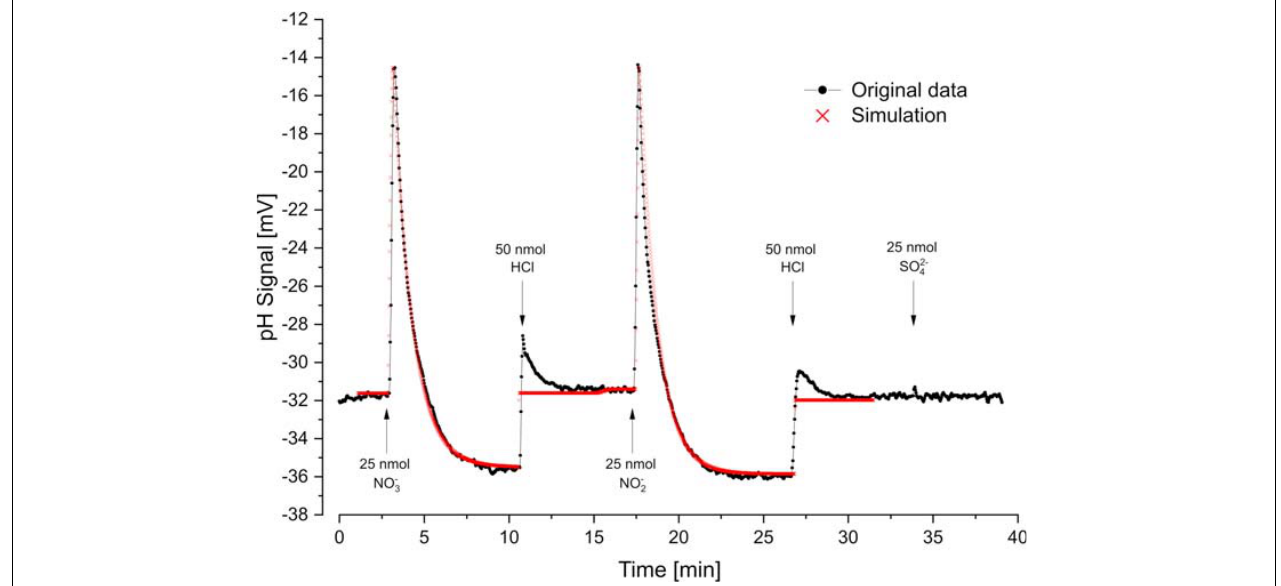
FIGURE 4 | Oxidant pulse experiment. Proton translocation coupled to nitrate- and nitrite reduction. Nitrate-grown cells were incubated under H 2 in the presence of KSCN (100 mM). Sulfate was not metabolized under these conditions. pH curves and proton translocation were simulated by means of proton.exe (parameters see Supplementary Material , standard deviations see Supplementary Table 1 ). The H + /e − ratio was additionally calculated by logarithmic extrapolation back to the time of electron acceptor addition (see Supplementary Figure 1